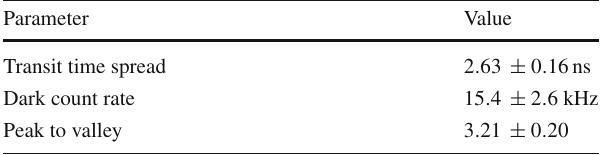
Fig. 7 Cross section of one iPMT assembly Table 1 Properties of the OSIRIS